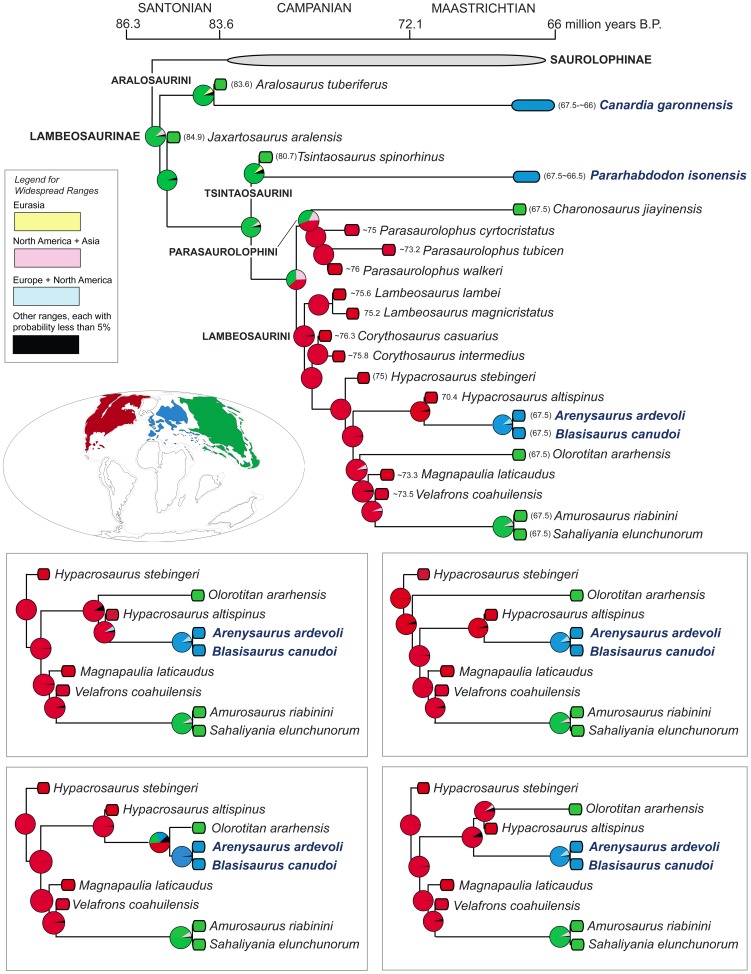
Time-calibrated phylogram of Lambeosaurinae based on the phylogenetic hypothesis shown in Fig. 25.The circles at each node represent the relative probabilities for the ancestral areas inferred via Dispersal Cladogenesis Extinction analysis (DEC [129]), implemented in RASP 2.0b [127].